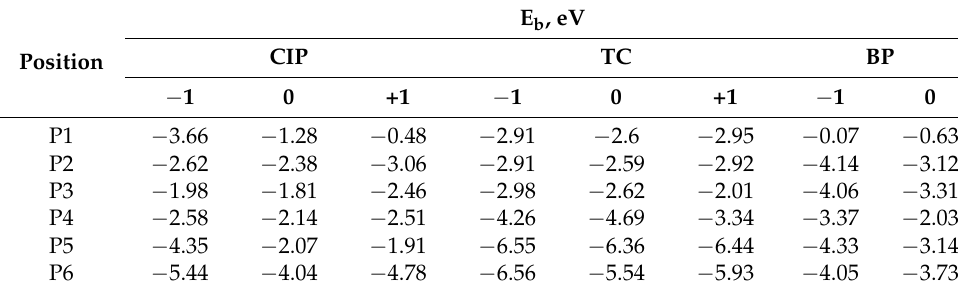
Table 2. Binding energies of antibiotics with BN surface.